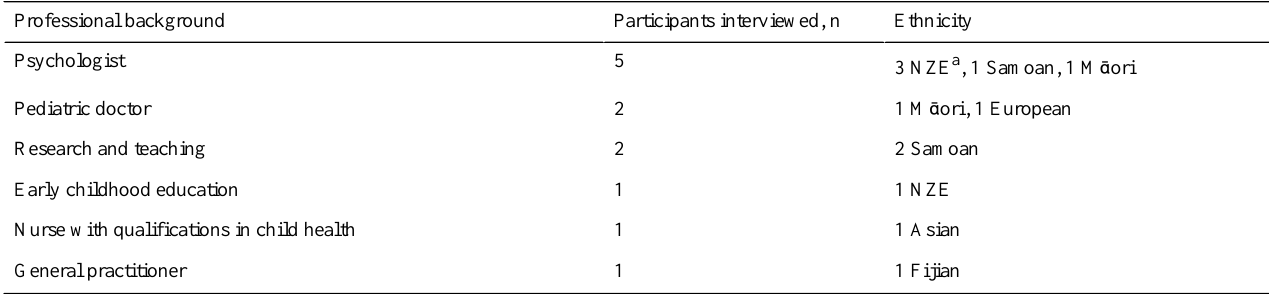
Table 2. Profession, ethnicity, and number of interviewees in the professional